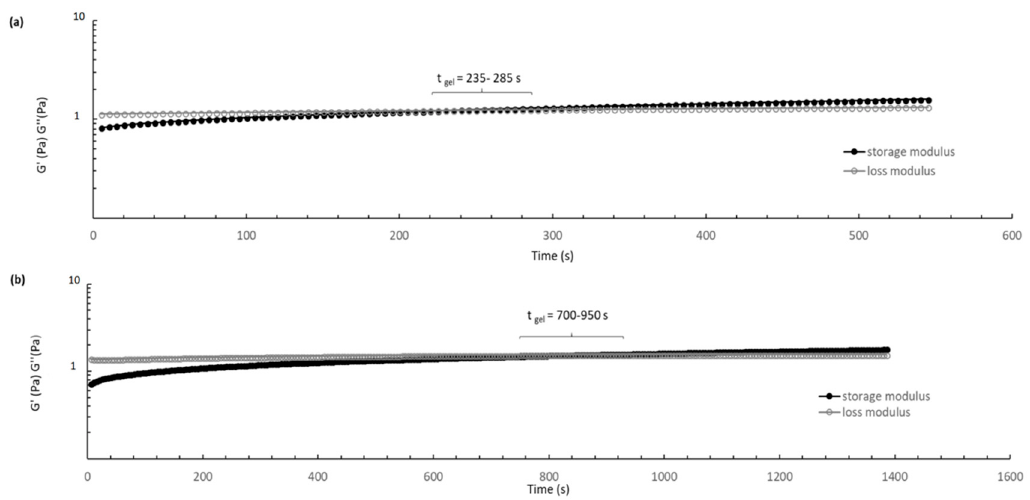
Figure 8. Time dependence of storage modulus (G ′ , •) and loss modulus (G ′′ , ○ ) of CS/ β GP ( a ) and CS/ β GP-NPs ( b ) formulations. The modulus was measured at 37.5 °C (sampling interval, 5 s) at a stress of 0.1 Pa and frequency of 1Hz.